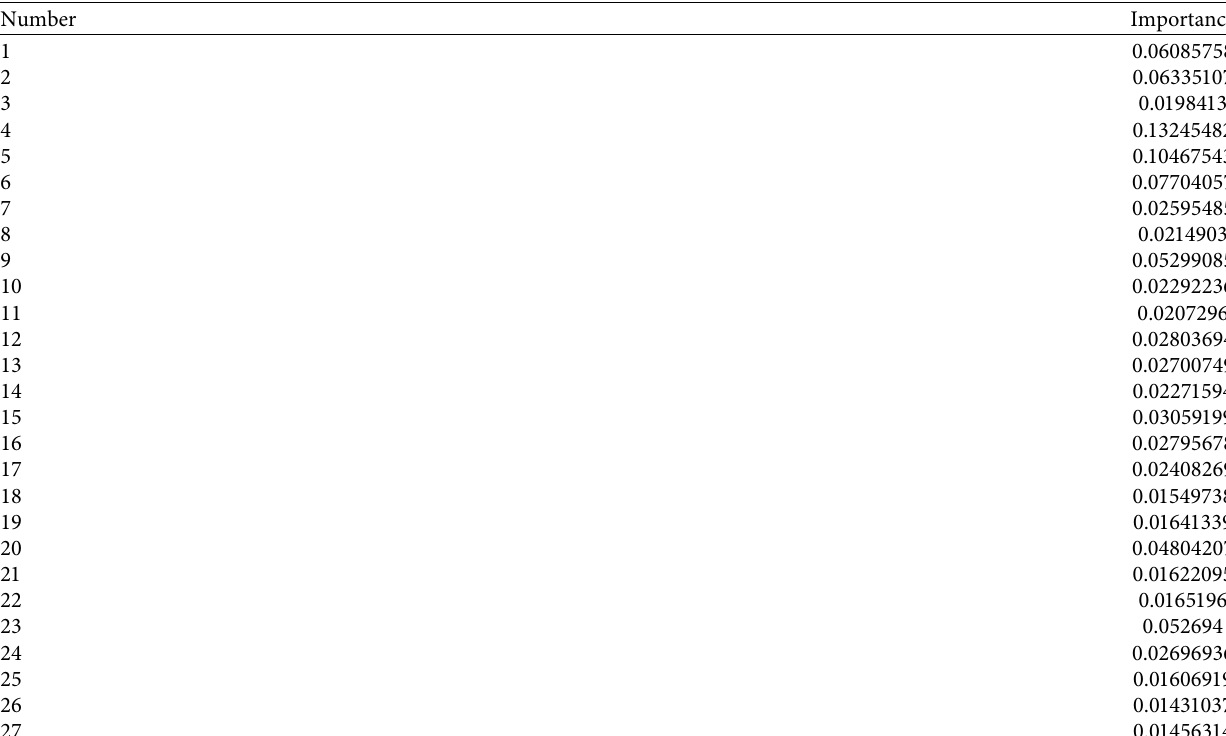
Table 2: Feature